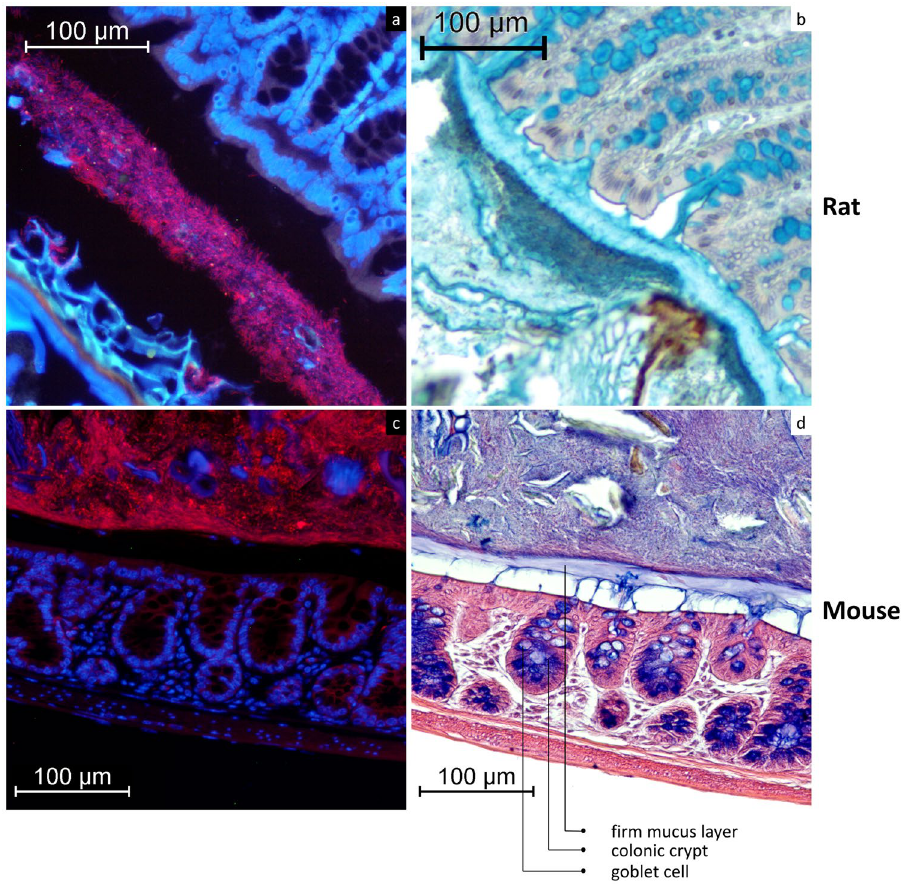
Figure 1. A firm mucus layer separates the bacteria from the epithelium. ( a ) FISH stained transversal section (Bacteria: red; nuclear staining DAPI: blue) of rat distal colon. ( b ) AB/H/E stained transversal section of rat distal colon. ( c ) FISH stained transversal section (Bacteria: red; nuclear staining DAPI: blue) of mouse distal colon. ( d ) AB/H/E stained longitudinal section of mouse distal colon. The FISH staining indicates where the bacteria are located, and that this corresponds to the dark blue/purple staining in AB/H/E stained